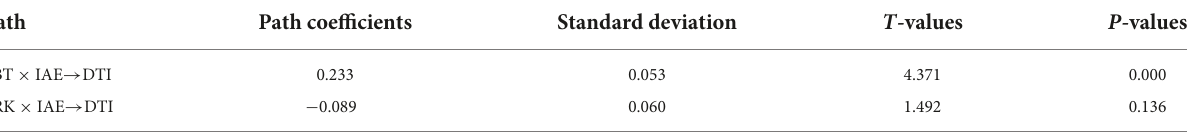
TABLE 5 Analysis of moderating